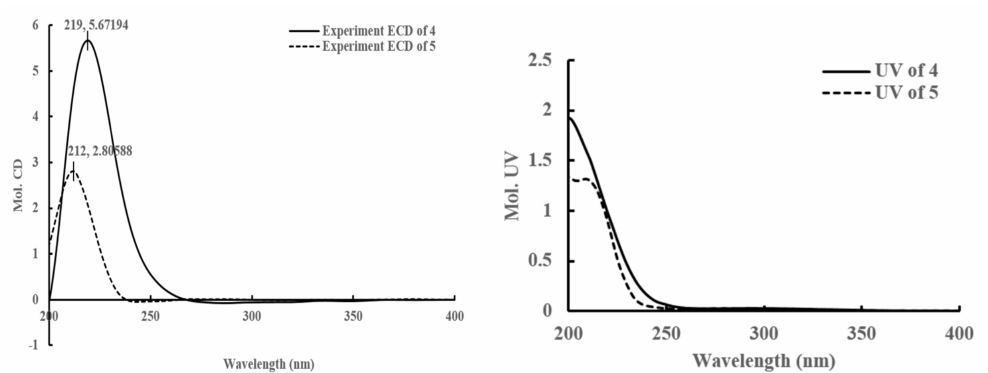
Figure 7. The CD and UV Spectrum of compounds 4 and 5 in